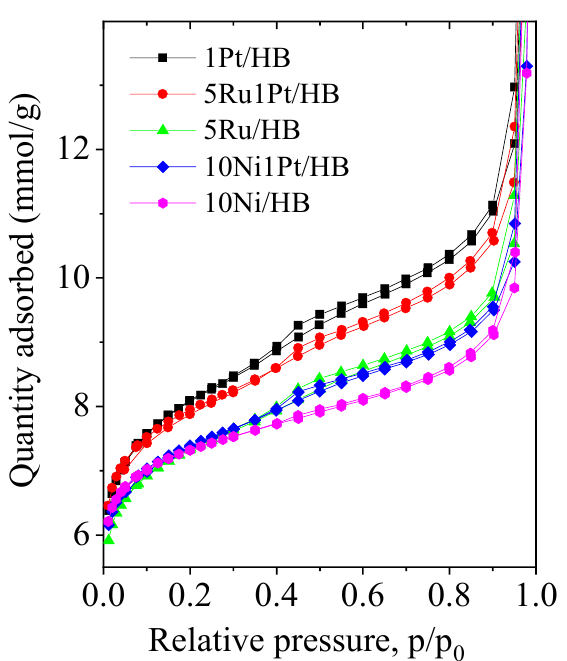
Figure 2. Nitrogen adsorption/desorption isotherms of Ni-, Ru-, and Pt-modified HB zeolites.